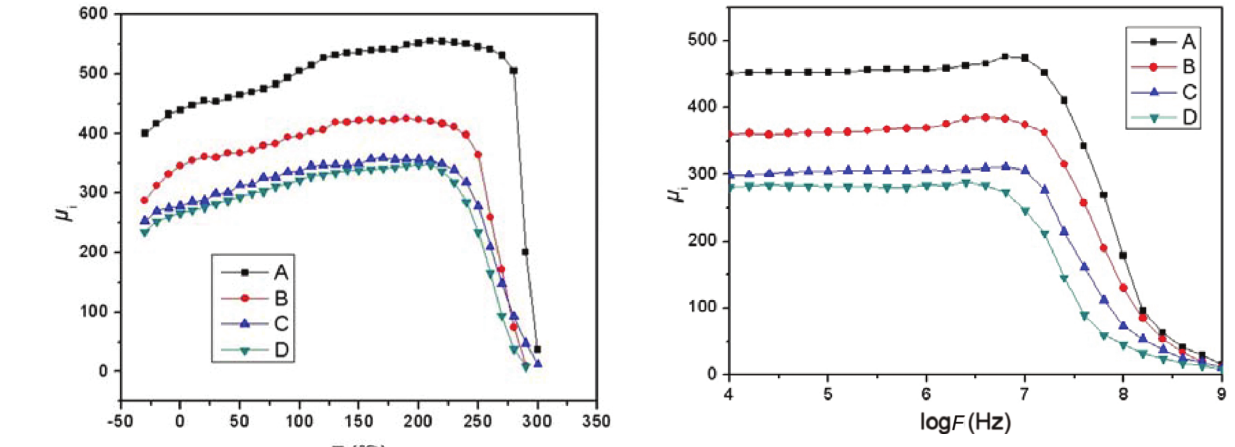
Figure 4: Frequency variation of initial permeability ( μ i ) for NiZn ferrite